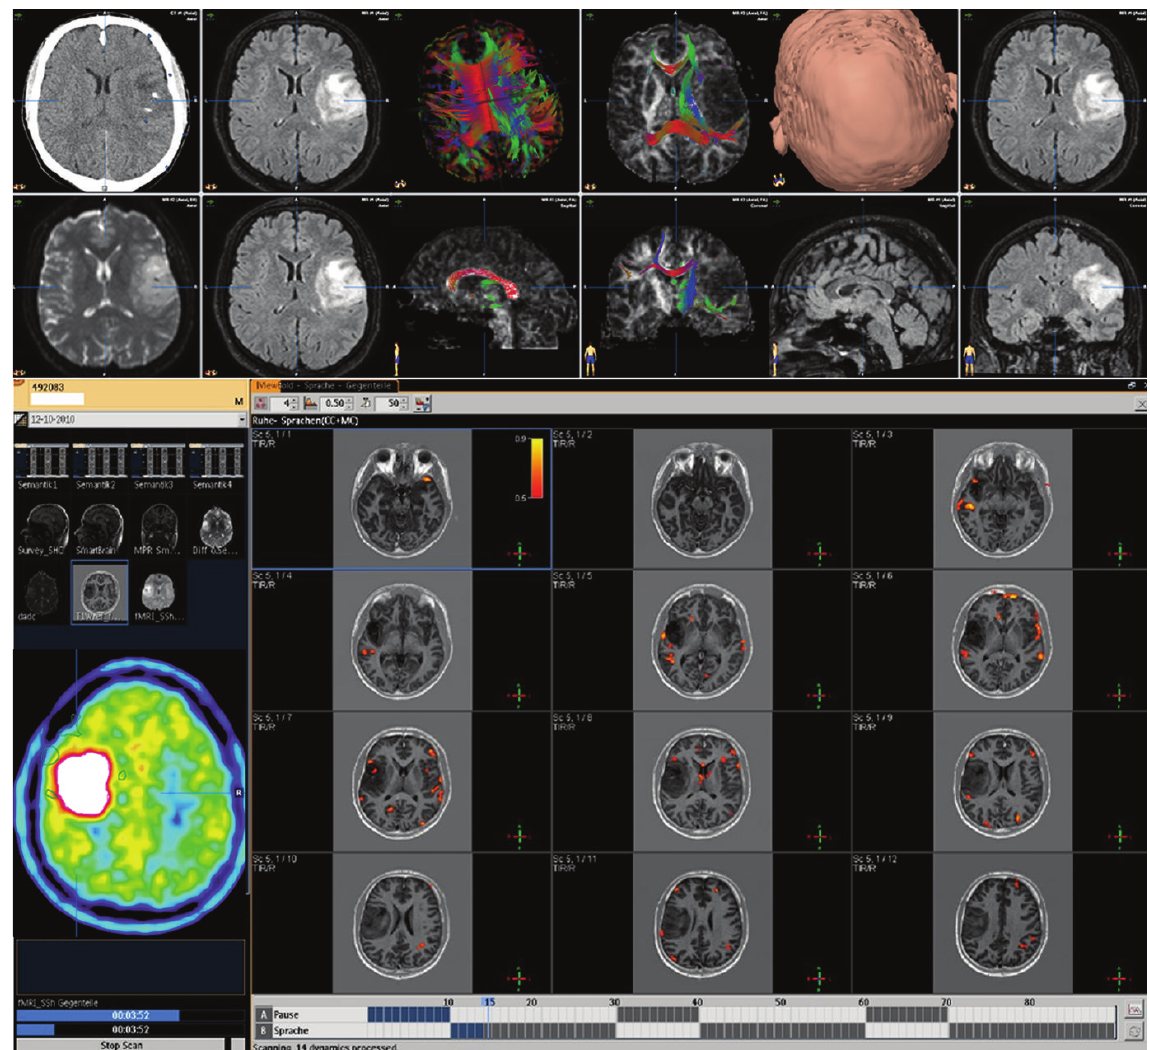
Figure 4: 3D volume data set combining CT images overlayed with FLAIR weigthed MRI, DTI tractography, and fMRI to define speech areas in a patient with a left parietal low grade